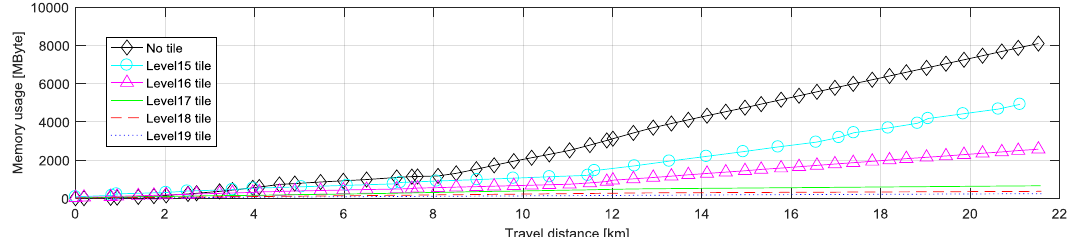
Figure 9. Memory usage for the various level tiles to evaluate the memory efficiency of the quad-tree tile